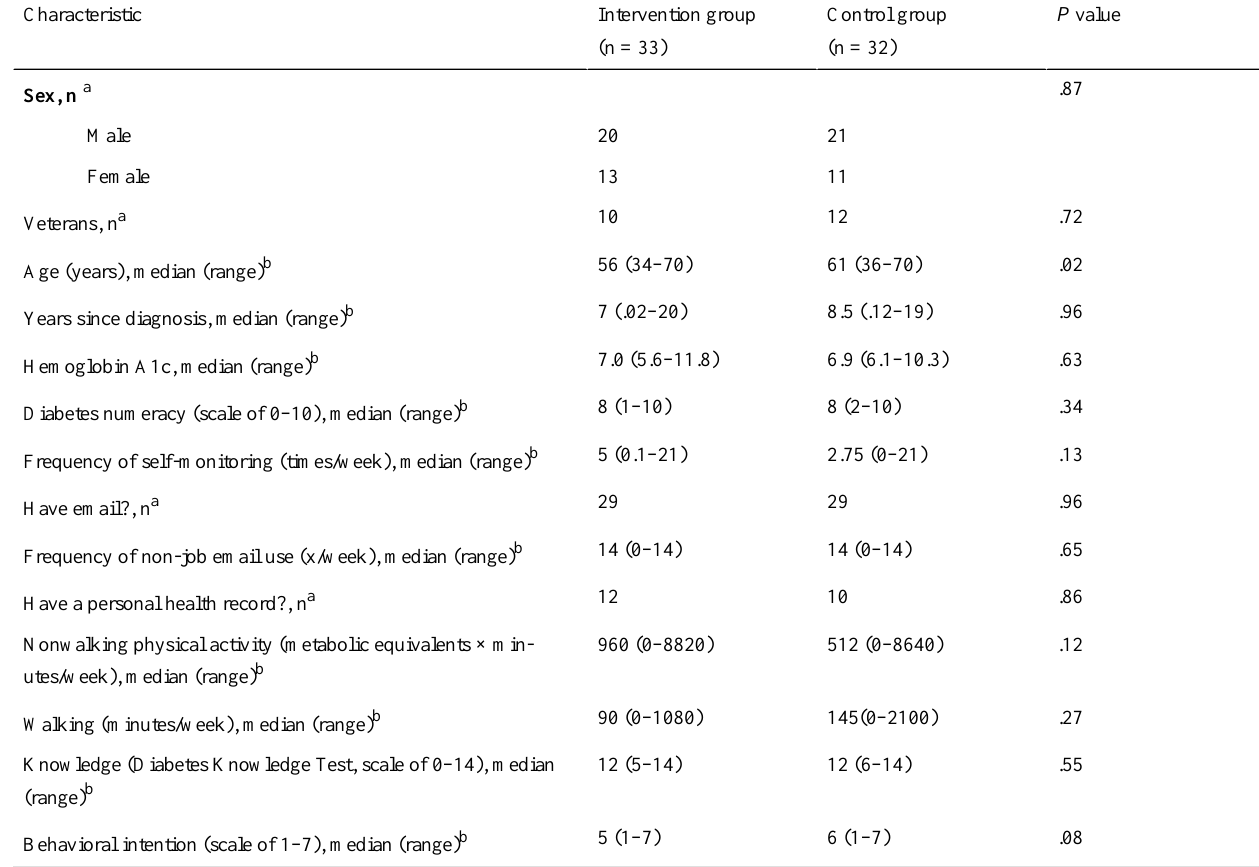
Table 2. Baseline characteristics of control and intervention